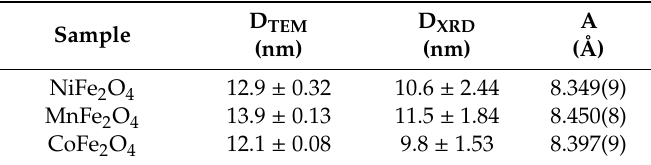
Table 1. Structural information of ferrite